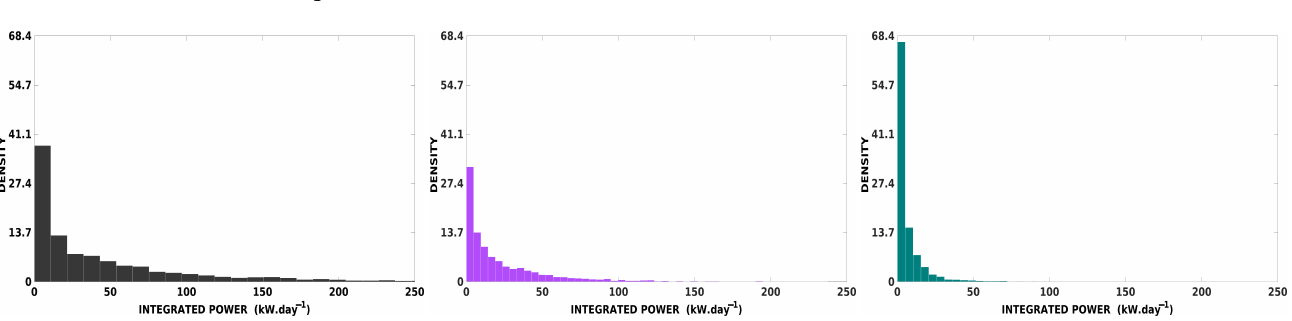
Figure 3. Probability density function of each site comparing percentage of time with the power output (kW · day − 1 ). ( left ) RS, ( middle ) SP, and ( right ) RJ. Table 1. Sites power analysis. Mean, standard deviation (Std), maximum (Max), and integrated (Int) power were compared against each